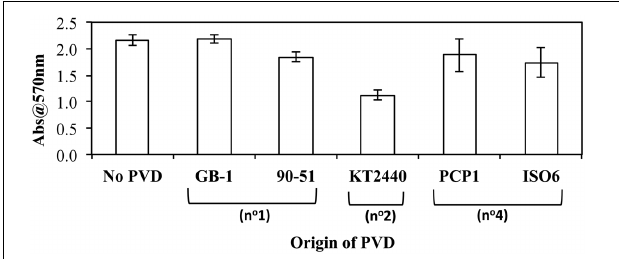
FIGURE 3 | Effect of exogenous PVDs on the growth of the P. putida GB-1 mutant (cid:2) PputGB1_4082. The medium was supplemented with 2 μ M FeCl 3 and 10 μ M of either: (i) no PVDs, (ii) PVDGB-1, (iii) PVD KT2440 , or (iv) PVD PCP1 .